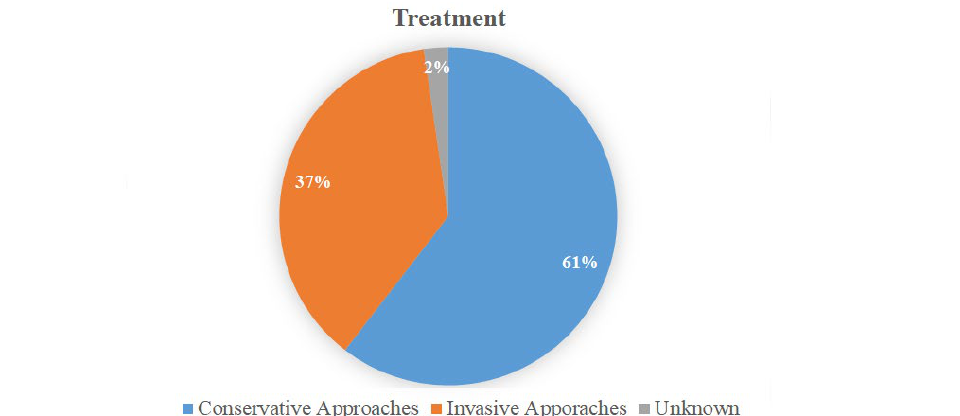
Figure 4. The treatment modalities used for aortic thrombus with COVID-19 infection